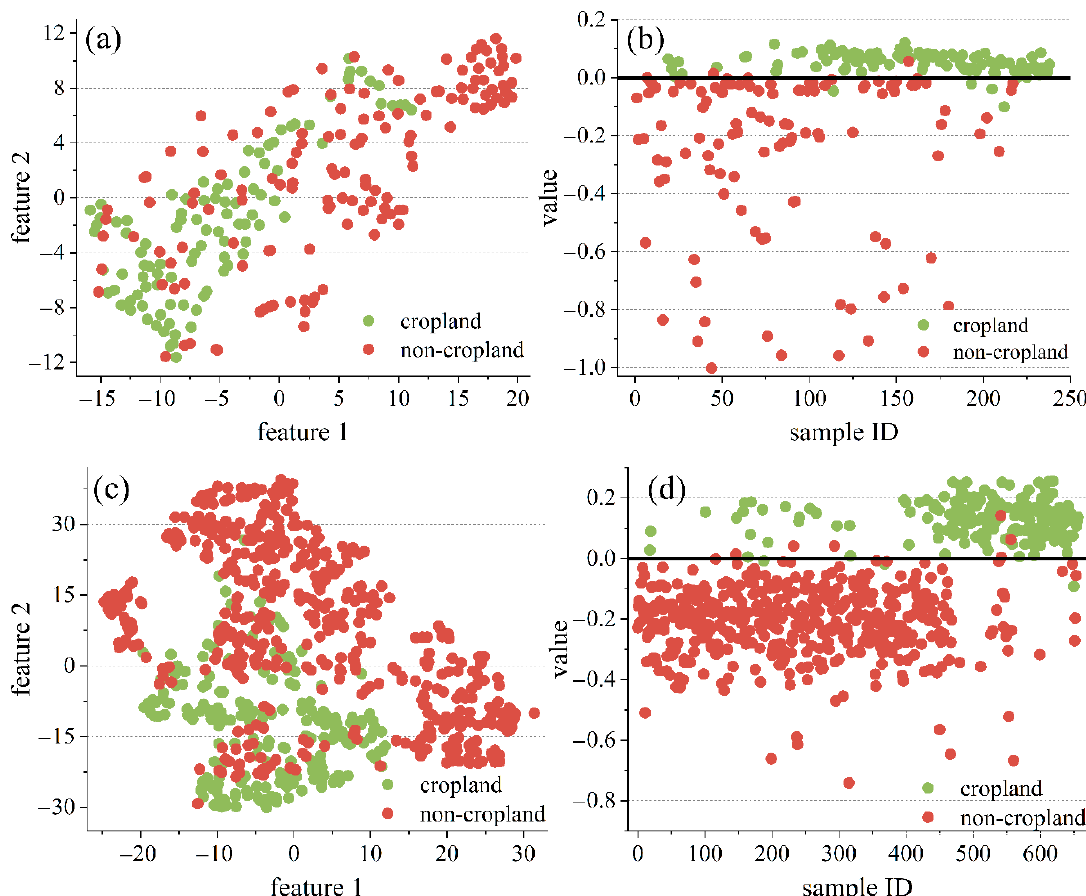
Figure 11. The visualization results in Area 1 ( a , b ) and Area 2 ( c , d ). The original features are reduced to two dimensions using t-Distributed Stochastic Neighbor Embedding (t-SNE) ( a , c ). The GP classifiers divide the samples using a threshold of 0 ( b , d ).